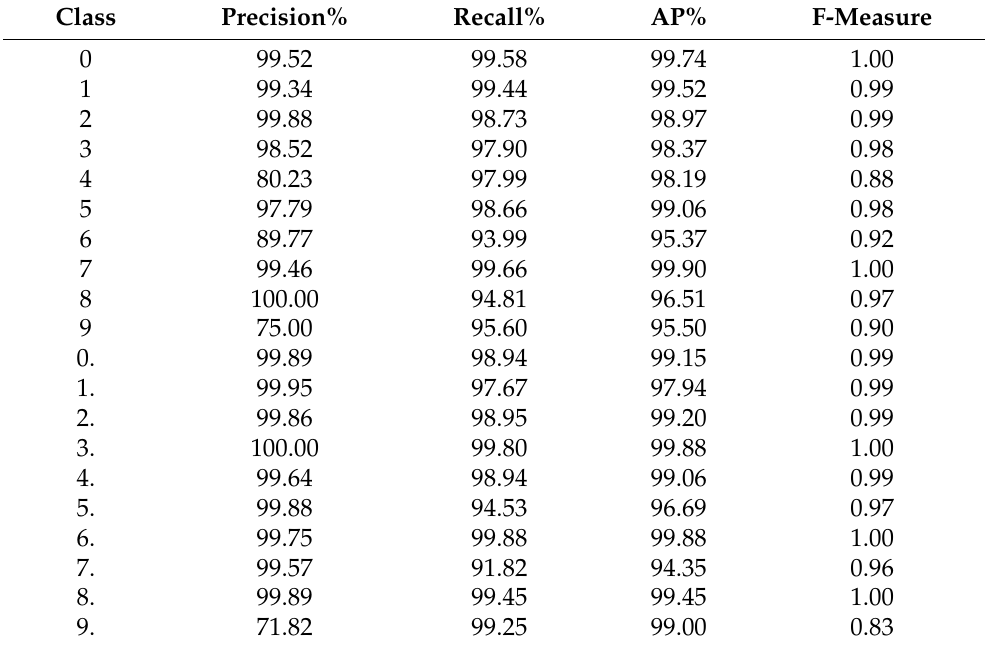
Table 3. Performance Indicators For Each Category.